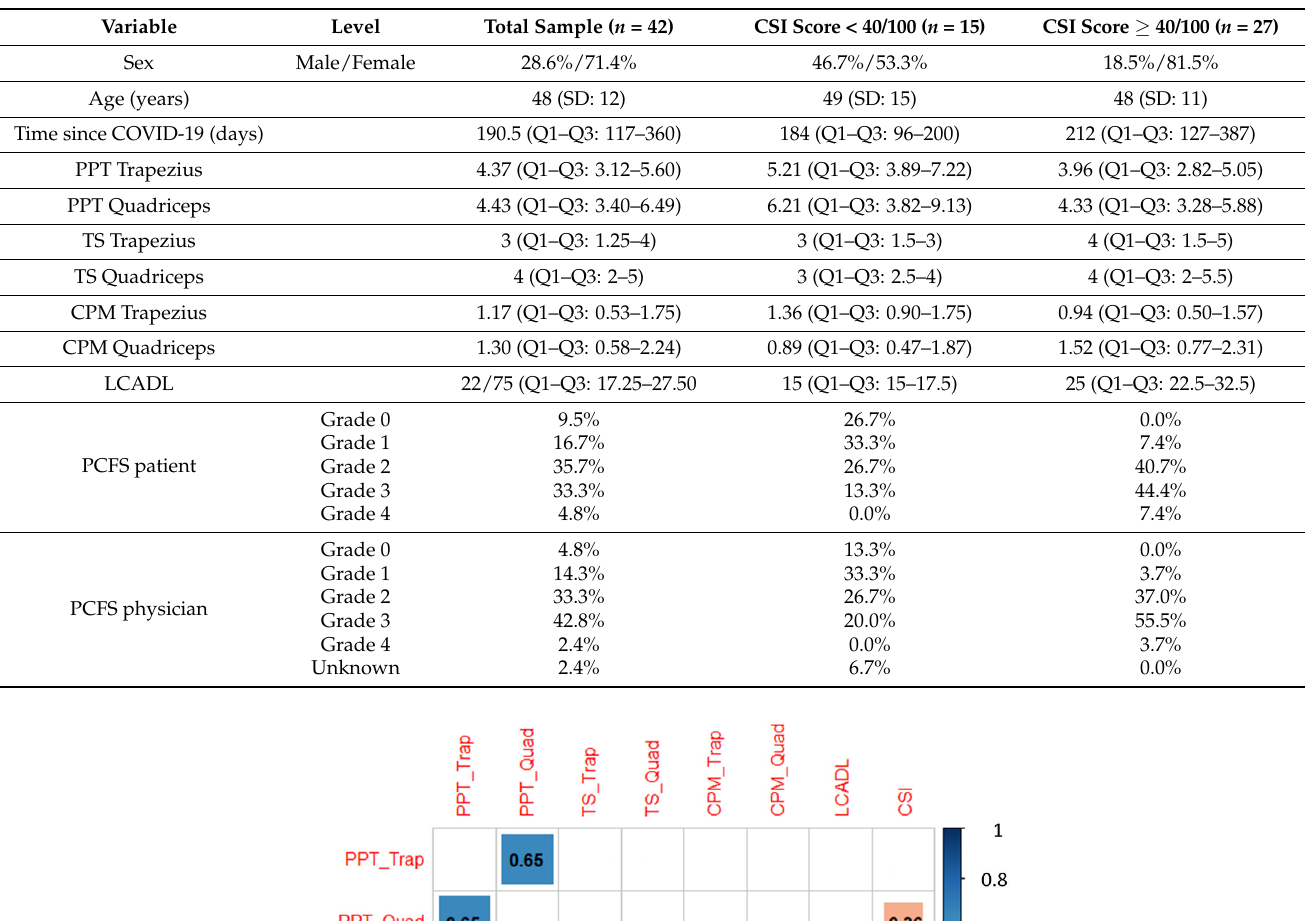
Table 2. Total scores on LCADL and PCFS, and results from experimental pain measurements from the complete sample, as well as those separated by the presence or absence (CSI < 40) of symptoms of central sensitization (CSI ≥ 40). Abbreviations: CPM: conditioned pain modulation,